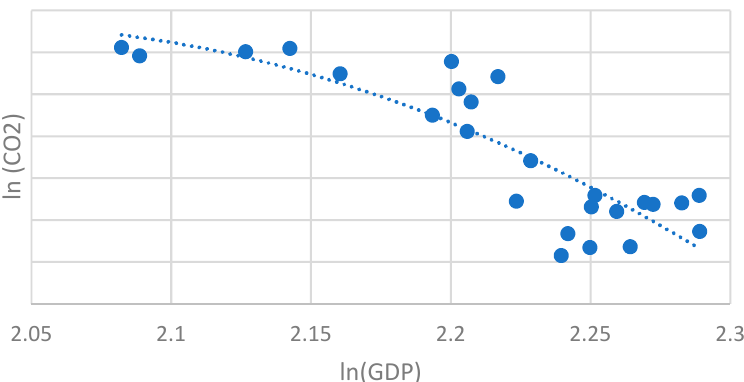
Figure 6. EKC for carbon emission and economic growth in developed countries. Source: Authors’ calculations.